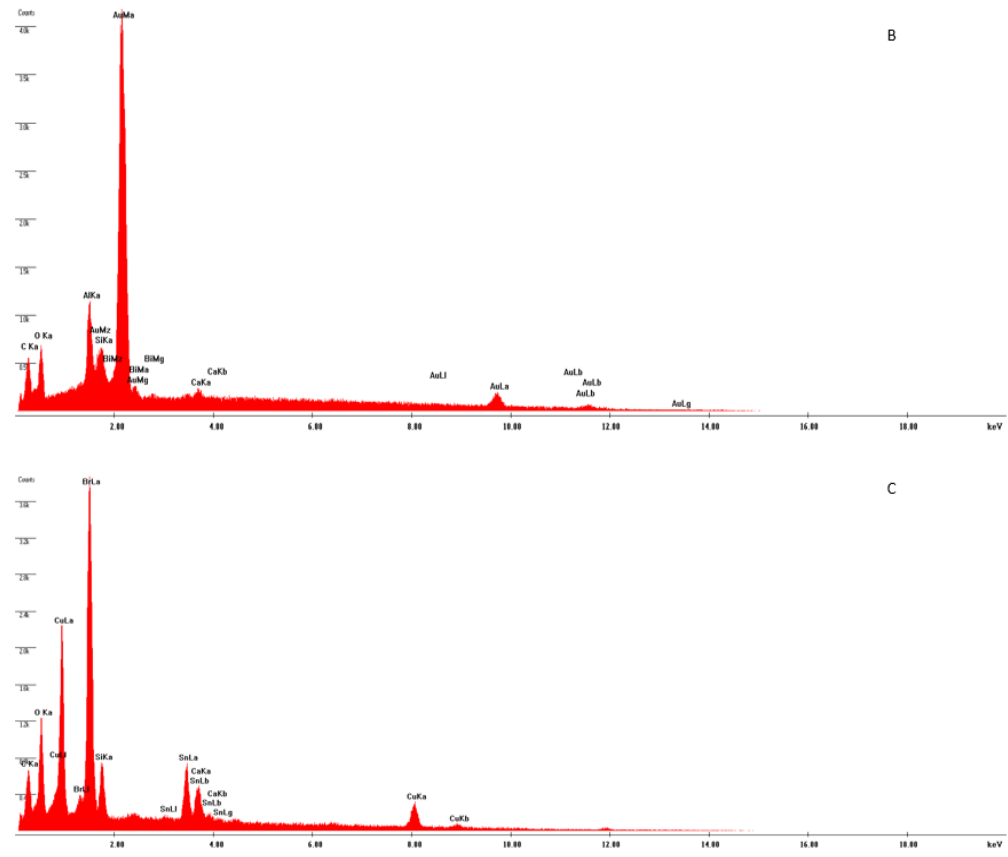
Figure 12. EDS spectra for Point B and C (BSE image).